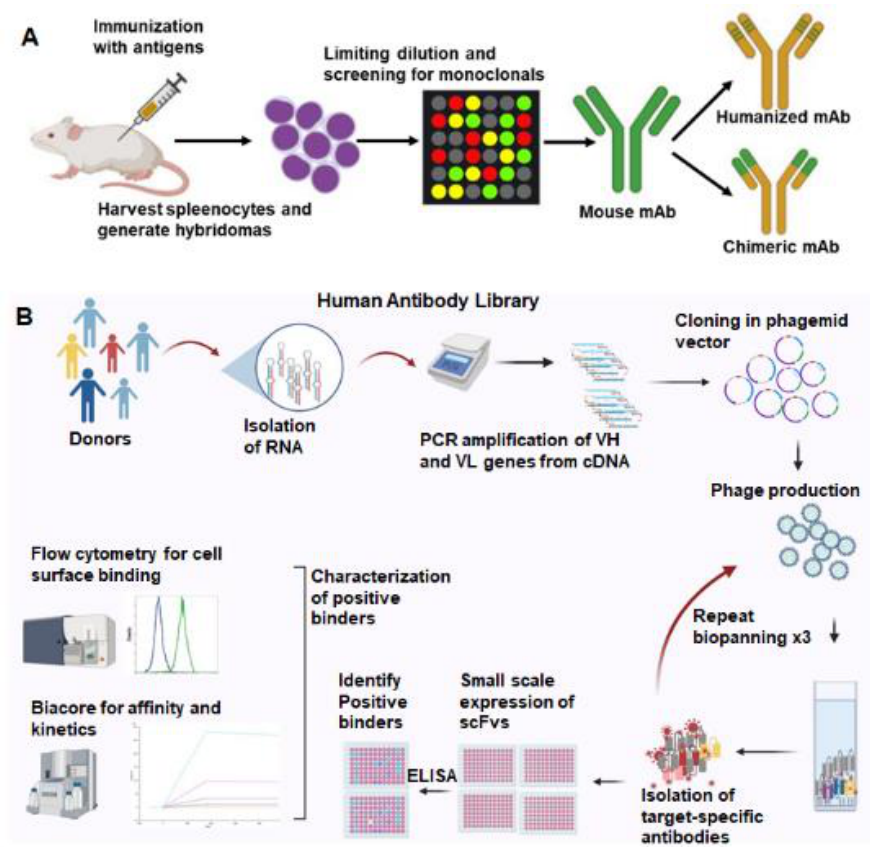
Figure 1. Two commonly used strategies for therapeutic antibody generation. ( A ). Mouse monoclonal antibodies are generated by immunizing mice with the target antigen. Splenocytes are harvested from immunized mice and fused with myeloma cells to create hybridomas. Selection and screening leads to identification of monospecific hybridoma clones that produce mouse monoclonal antibodies. Fv region of the human antibody backbone can be swapped with the murine Fv, generating a chimeric antibody. ( B ). Phage-displayed human antibody library screening can yield human antibodies against the target. Libraries are created by isolating RNA from peripheral blood and spleens of healthy donors. VH and VL genes are amplified from the cDNA and cloned into phagemid vectors. Phage- expressing antibodies on their surface were produced. Multiple rounds of phage-antibody selection are performed to isolate target-specific antibodies. Positive binders are screened by ELISA, flow cytometry, and affinity to select the lead antibodies. Created with